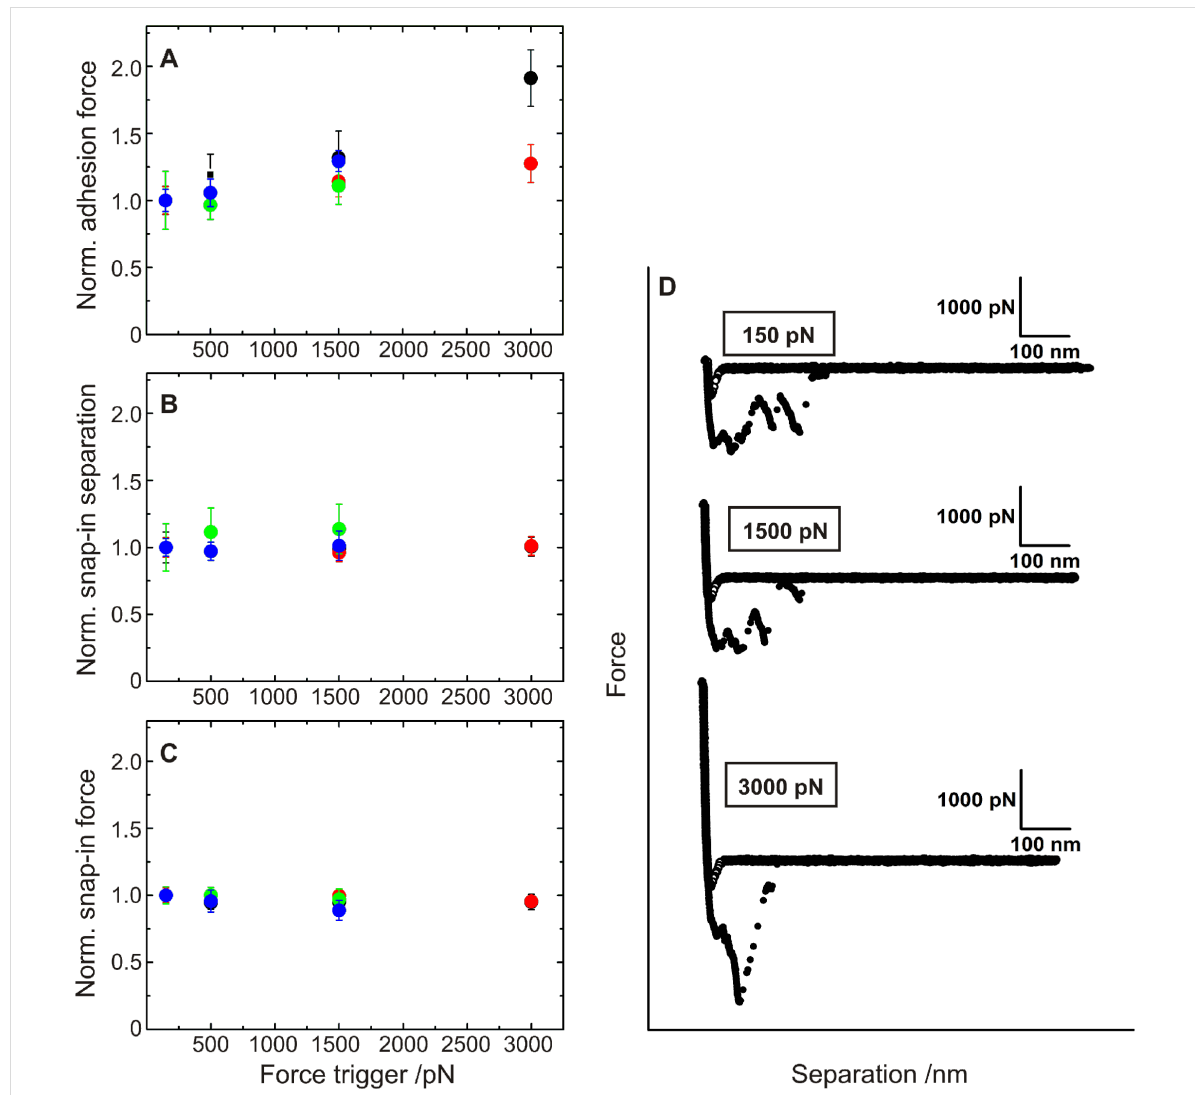
Figure 6: Influence of the force trigger on the adhesion of S. carnosus . A–C: For four bacterial probes, values for adhesion force, snap-in force, and snap-in separation are normalized to the value of the measurement with the lowest force trigger (150 pN). D: Exemplary force/distance curves for the exact same bacterial probe for three different force triggers. Different colors represent different bacterial probes.